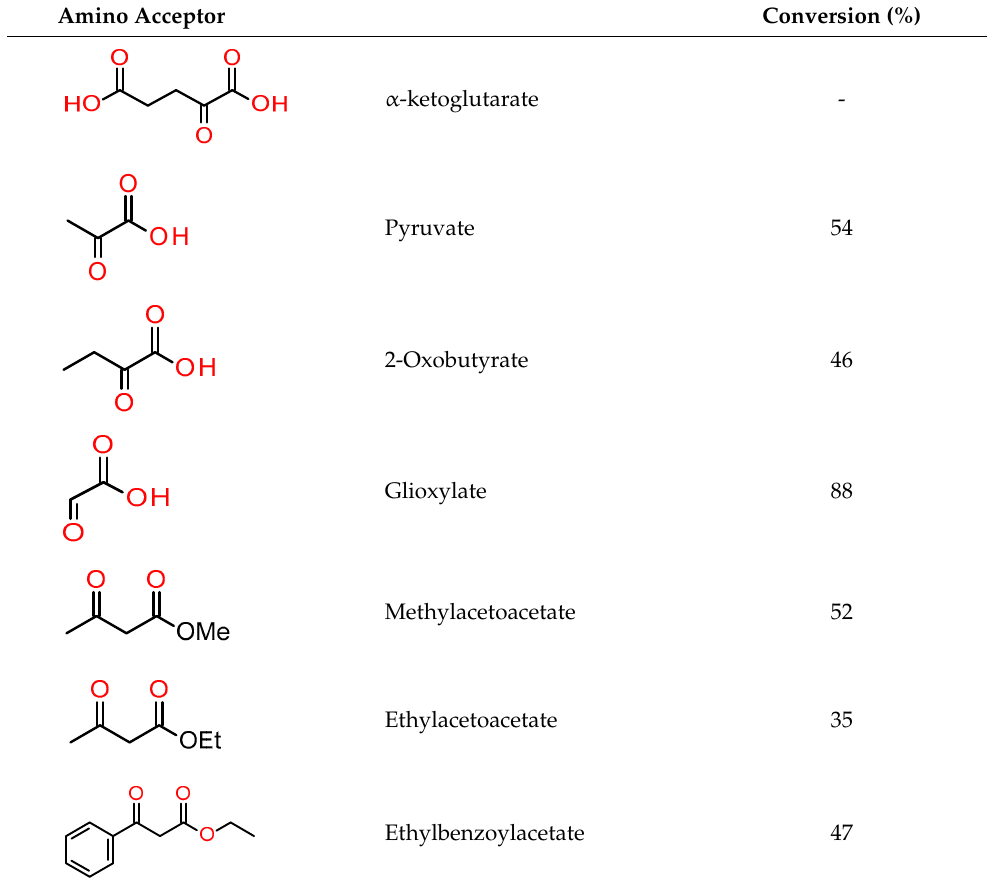
Table 3. Amino acceptor spectrum of Table 3. Amino acceptor spectrum of Sbv333-TA. Table 3. Amino acceptor spectrum of Sbv333-TA. Table 3. Amino acceptor spectrum of Sbv333-TA. Table 3. Amino acceptor spectrum of Sbv333-TA. Table 3. Amino acceptor spectrum of Sbv333-TA. Table 3. Amino acceptor spectrum of Sbv333-TA. Table 3. Amino acceptor spectrum of Sbv333-TA.